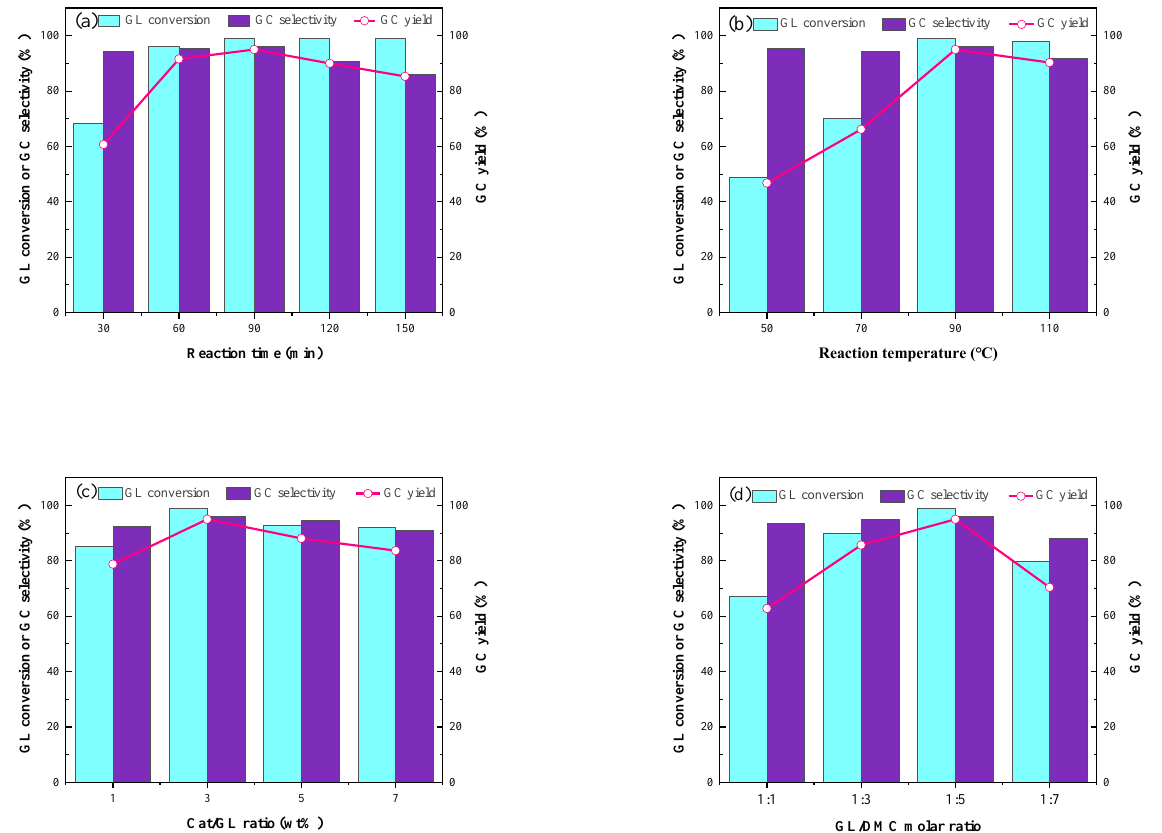
Figure 7. Effect of reaction conditions on the GL transesterification over Mg1Zr2-HT catalyst: ( a ) effect of reaction time (GL/DMC molar ratio = 1/5, catalyst amount = 3 wt% of GL, 90 ◦ C), ( b ) effect of reaction temperature(GL/DMC molar ratio = 1/5, catalyst amount = 3 wt% of GL, 90 min), ( c ) effect of catalyst amount(GL/DMC molar ratio = 1/5, 90 ◦ C, 90 min), ( d ) effect of GL/DMC molar ratio(catalyst amount = 3 wt% of GL, 90 ◦ C, 90 min).